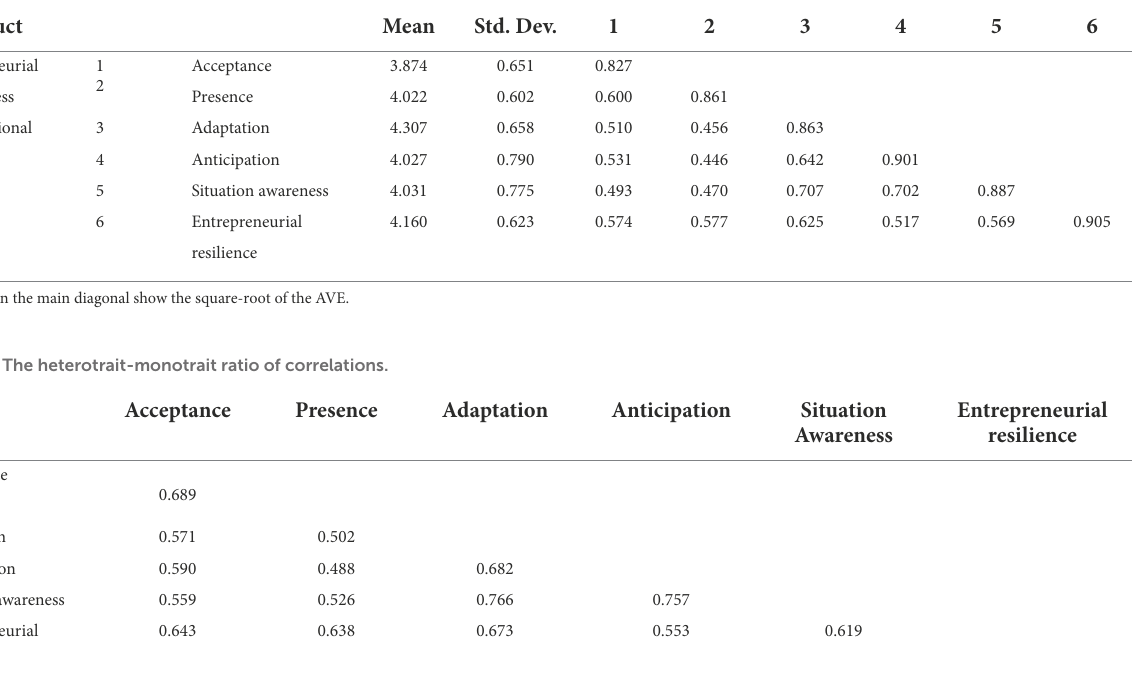
TABLE 4 Descriptive statistics and construct